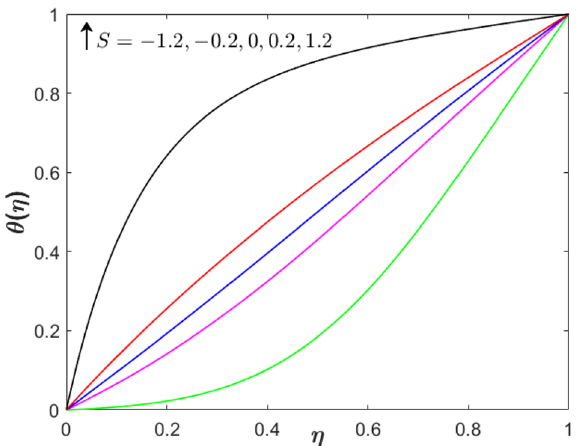
Figure 5. Effect of suction/injection parameter on θ(η) when (cid:31) = 0 , Sq = M = 1 and φ 1 = φ 2 = 0.01 .